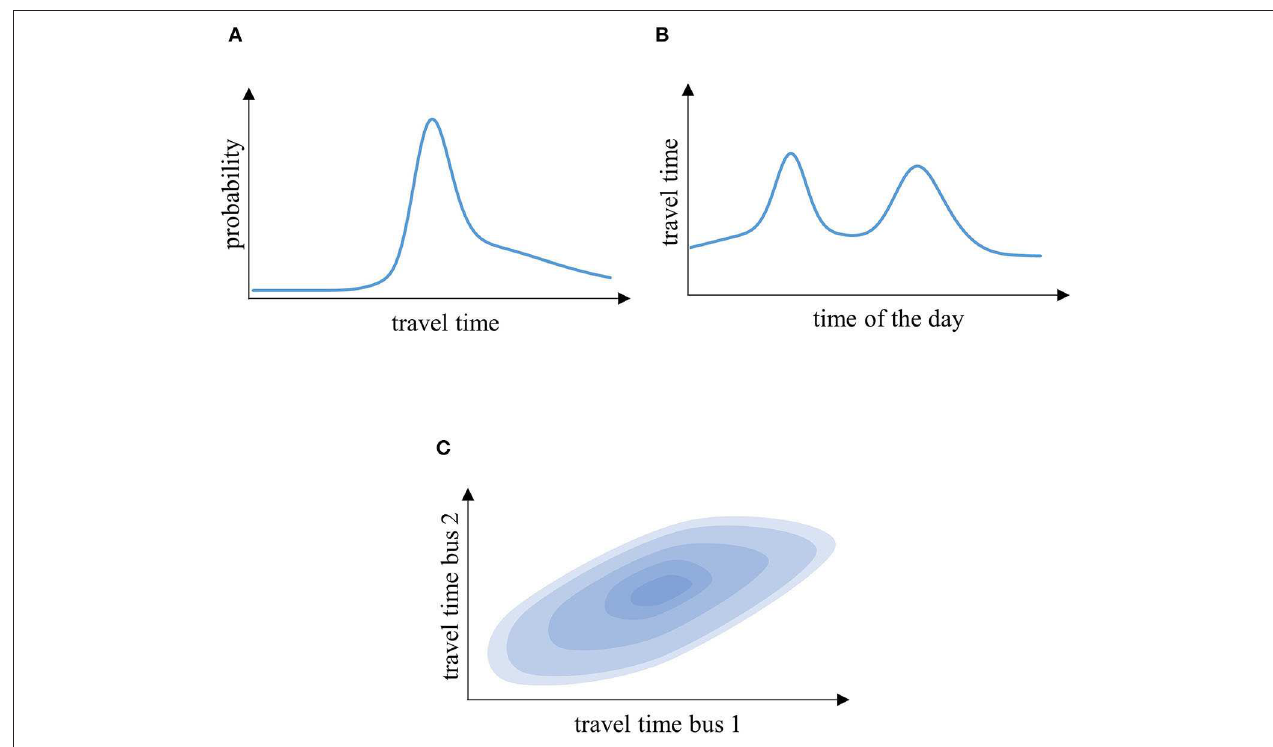
FIGURE 1 | Typical representation explaining (A) day-to-day variability, (B) variability over the course of a day, and (C) vehicle-to-vehicle